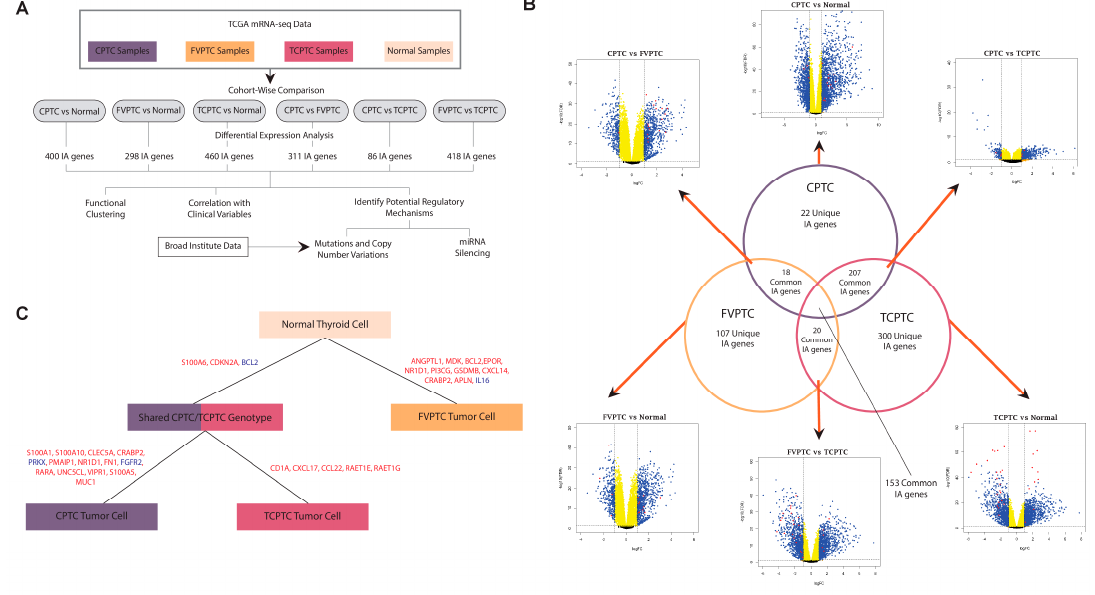
Figure 1. Study overview and di ff erential expression analysis. ( A ) Schematic of analyses and workflow. ( B ) Venn diagram illustrating the unique and common significantly dysregulated IA genes after di ff erential expression analysis of samples from each type vs. normal samples. Volcano plots depict statistical significance and fold change of di ff erential expression analyses for all CA and IA genes. Red datapoints represent genes with expression that correlates with MACIS score. ( C ) Schematic of dysregulated genes that characterize each PTC subtype. Both di ff erential expression results and clinical variable correlations results were used to determine the most important genes to each subtype. Gene names labeled in blue represent downregulation in a subtype and red represents upregulation in a subtype.